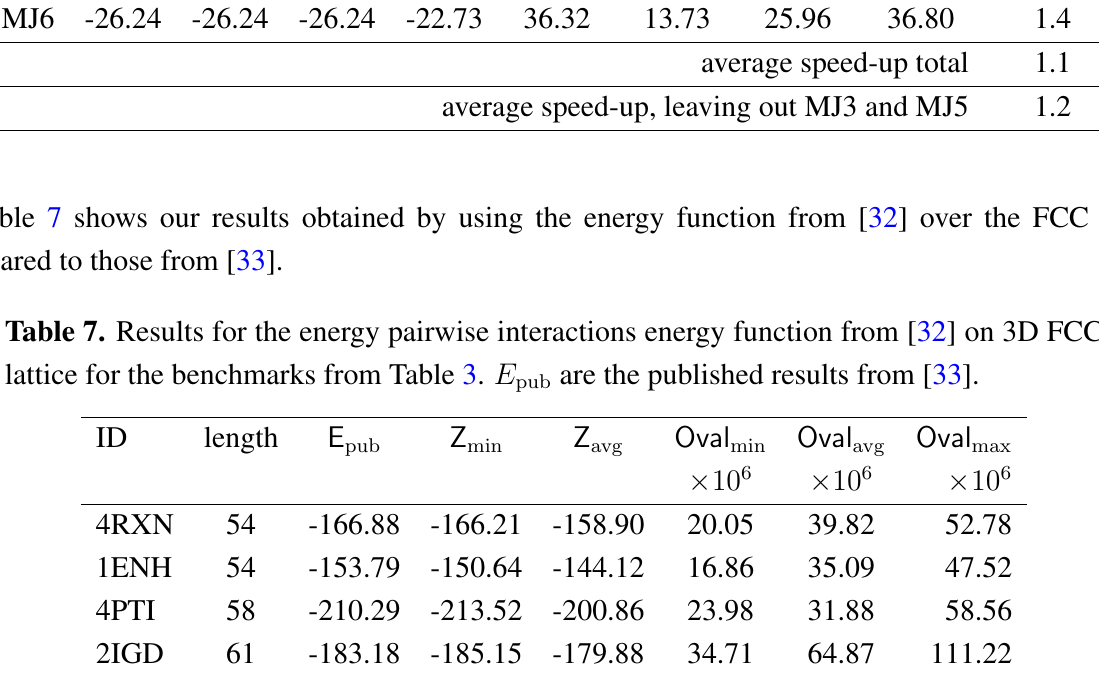
are the average energy function evaluation counts avg